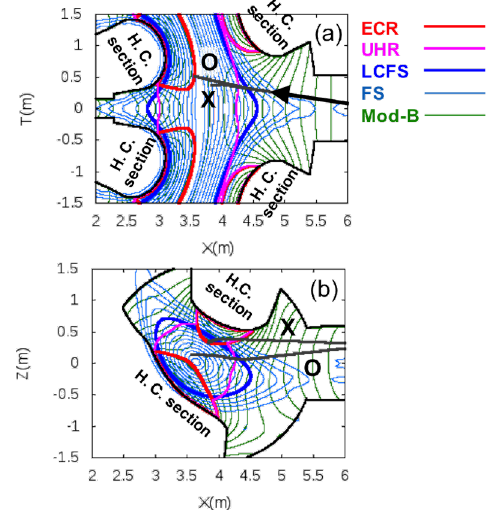
Fig.3: Trajectories of the O and X modes calculated by ray - tracing with use of the fitted profile shown in Fig.4. (a): projection on the equatorial plane. (b): projection on a plane vertically sliced along the launched beam indicated by a black arrow drawn in (a). Contours of the ECR layer, UHR layer, flux surfaces, LCFS and Mod-B surfaces are also